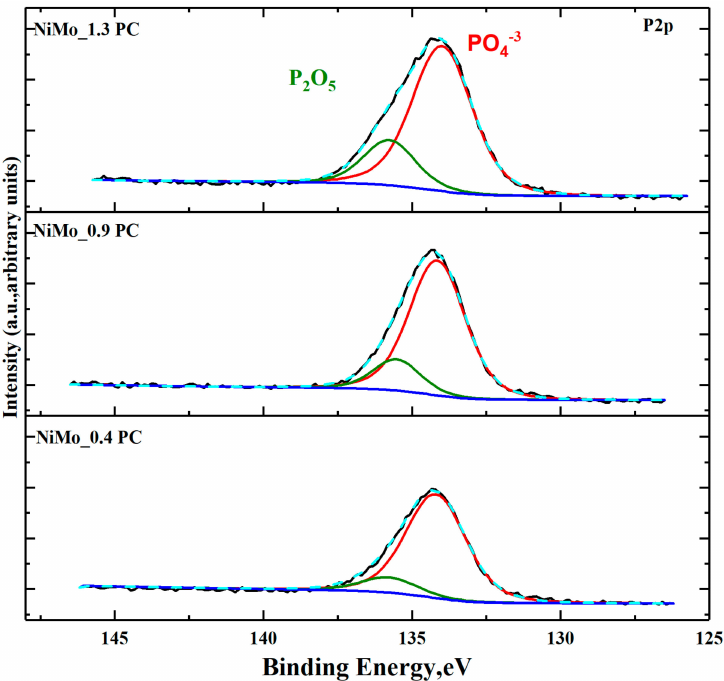
Figure 7. P2p core level spectra for the recovered catalysts with PC.